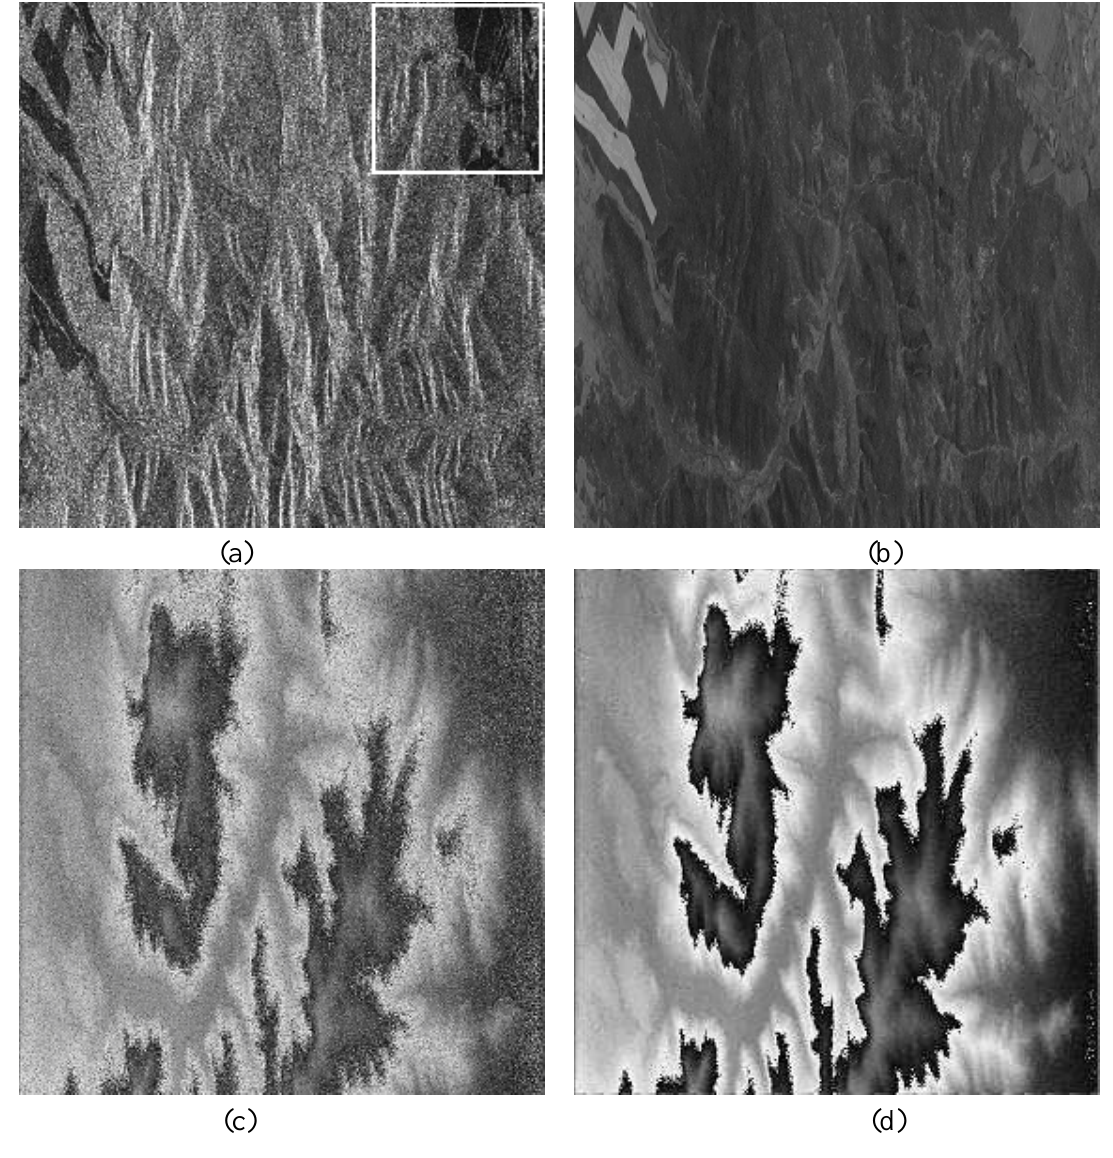
Figure 5. (a) The amplitude image in HH channel of mountain test area. (b) The corresponding optical image from Google Earth. (c) The phase in HH channel. (d) The phase obtained by the AO method in the ML